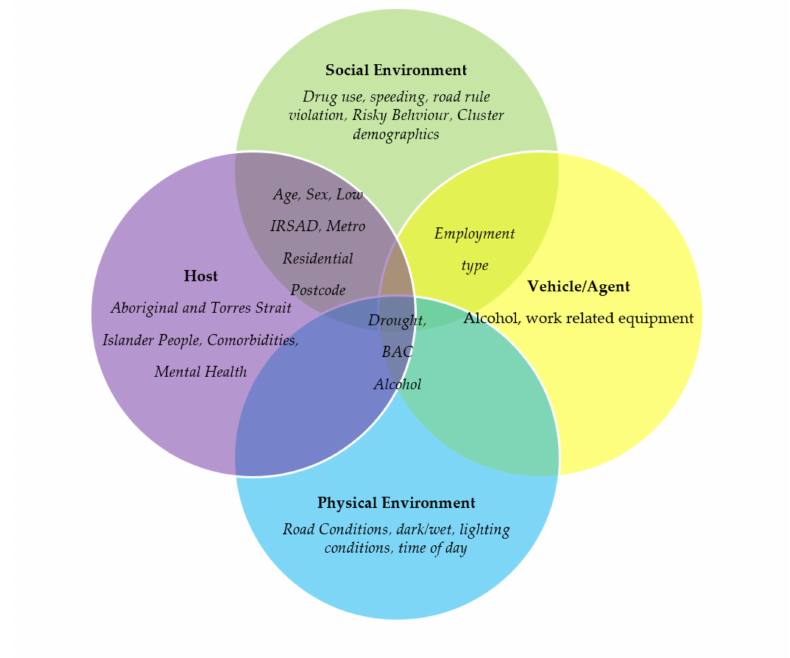
Figure 2. Interconnecting Relationship of Haddon Matrix Risk Factors (Road